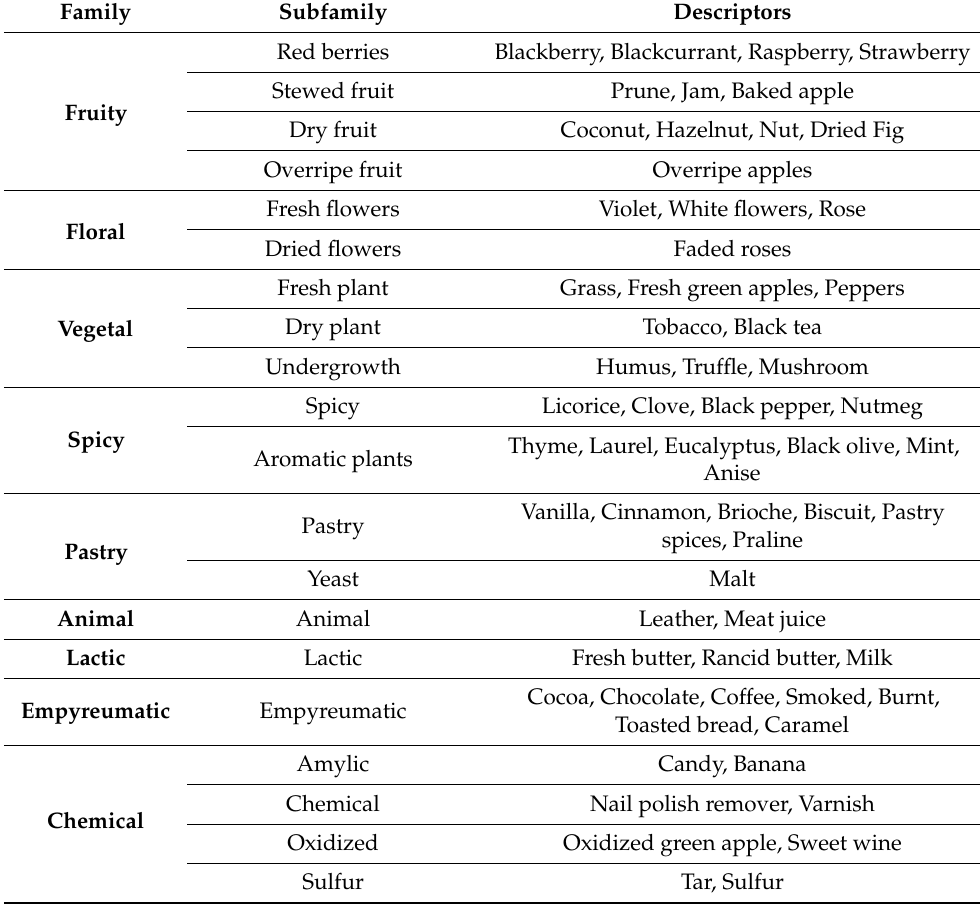
Table 1. List of families and 20 sub-families and olfactory terms used for the HCATA